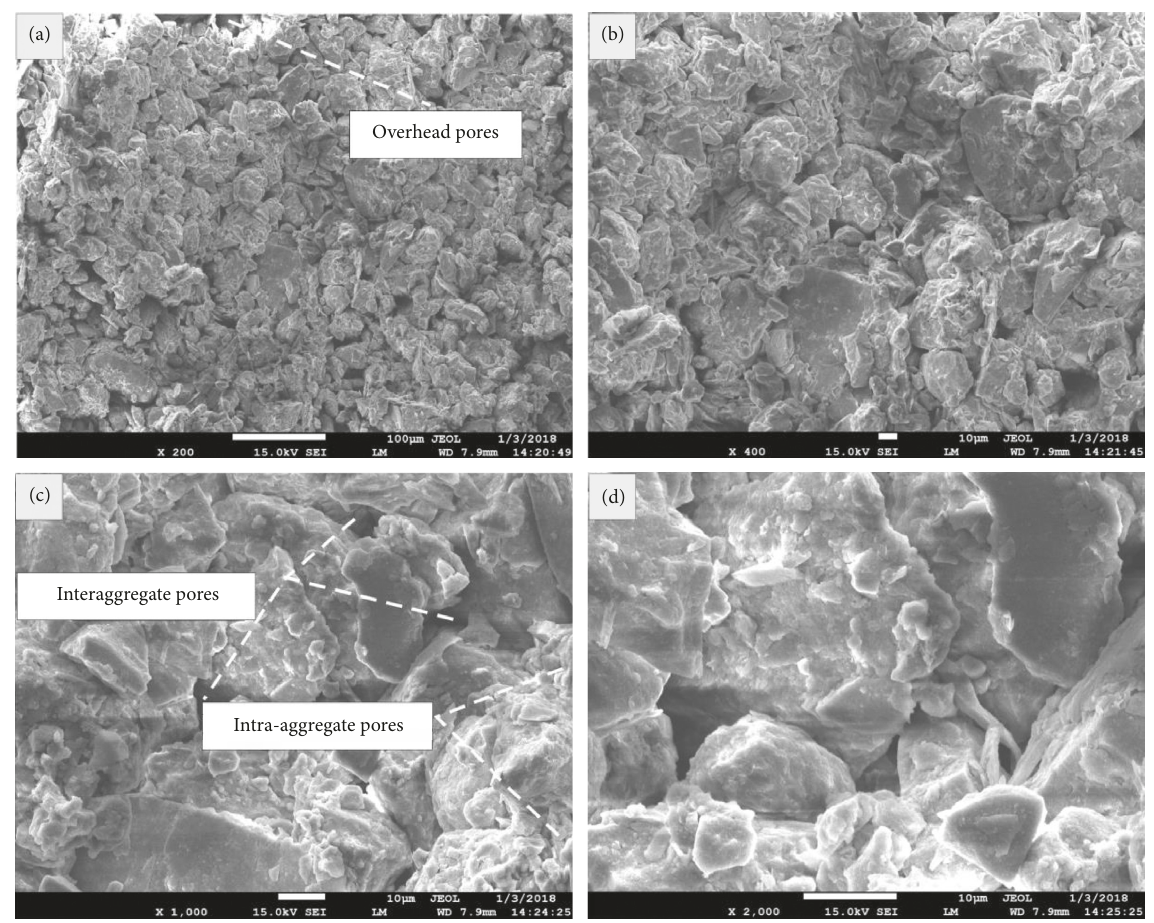
Figure 5: SEM photographs of loess compacted at dry of optimum under different magnification: (a), (b), (c), and (d) are under magnification of 200, 400, 1000, and 2000,